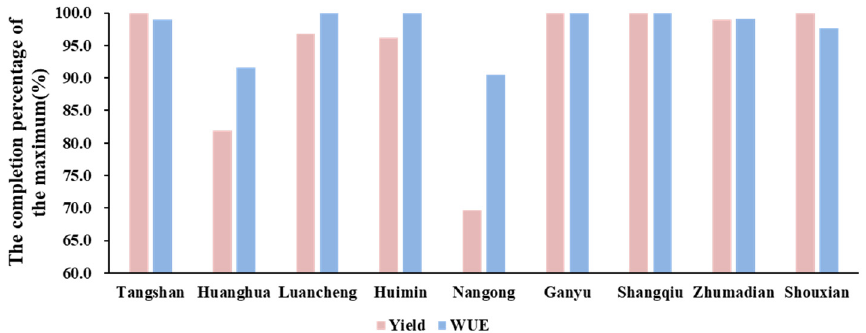
Figure 7. The completion percentage of the maximum yield and water use efficiency (WUE) based on the OI .